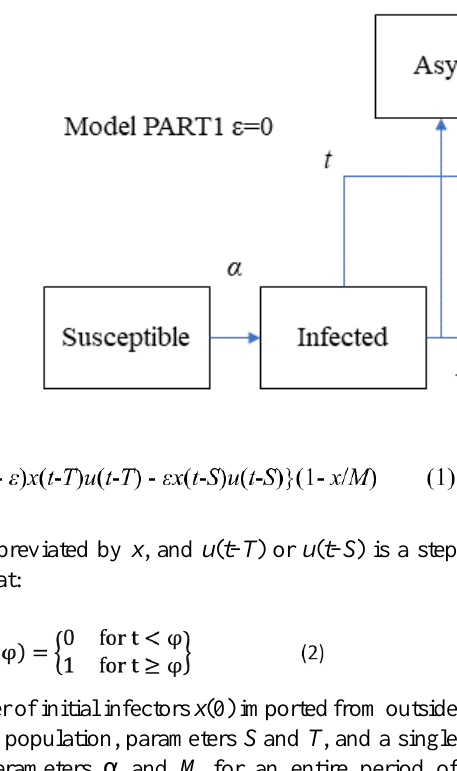
Figure 1. Concept of the present epidemic model. Two paths from newly infected until removed (recovered/died) are shown, with symptomatic and asymptomatic paths. The portion of the former is ε and the latter 1– ε . The former remains infectious in the time period [ t , t + T ] and the latter [ t , t+S ], with T < S (typically). We call the case ε =0 model PART1 and 0< ε <1 model PART2. The case ε =1 is equivalent to the standard SIR model, in which no distinction exists between symptomatic and asymptomatic